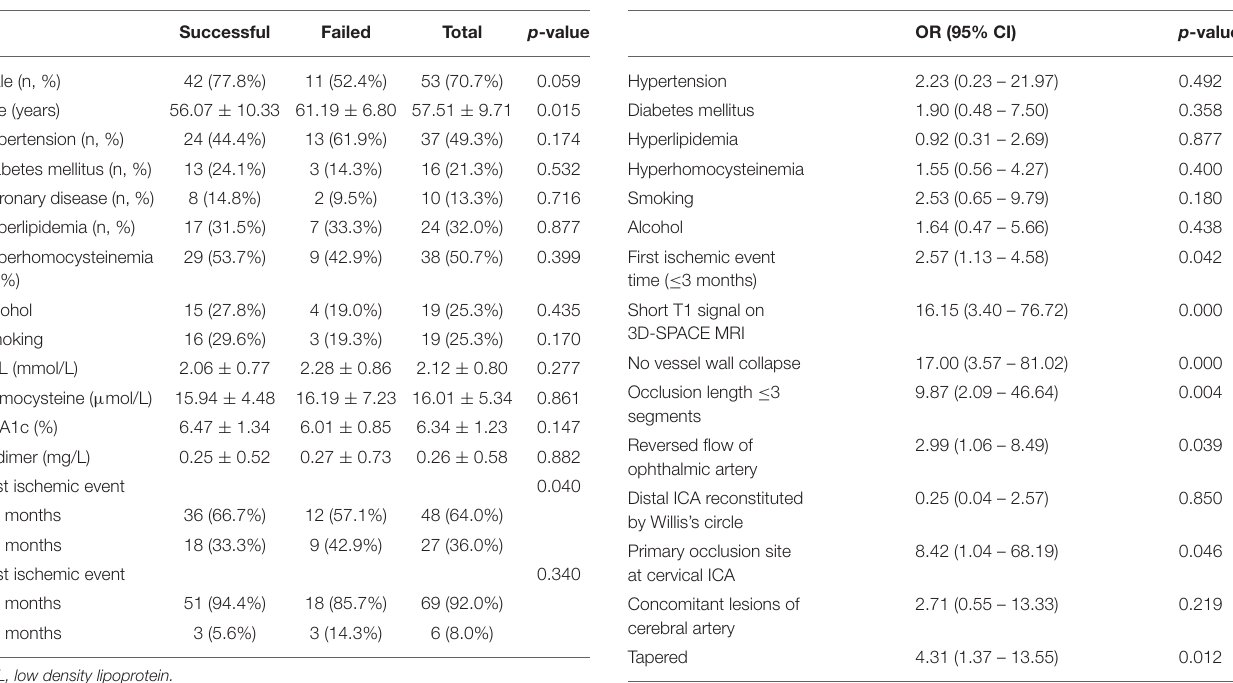
TABLE 3 | Logistic regression for predictors of technique